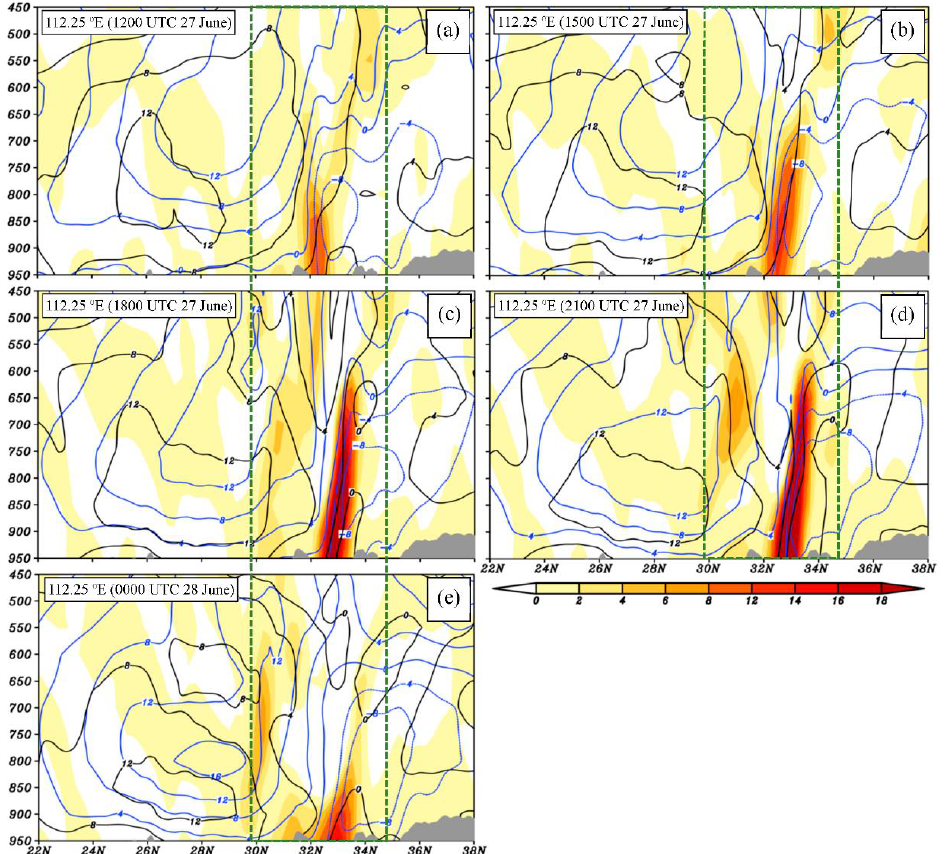
Figure 5. Panels ( a – e ) show the zonally (from 109.25° E to 115.25° E) averaged term STR (shading, units: 10 −9 s −2 ), zonal wind (blue lines, units: m s −1 ), and meridional wind (black lines, units: m s −1 ). Grey shading shows the terrain, and the green dashed lines mark the central location of the mesoscale vortex. Y labels in all figures are pressure (units: hPa).